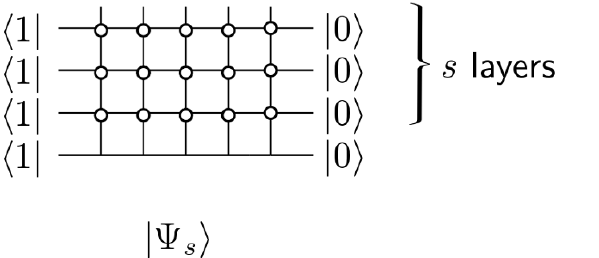
Figure 17 . An MPS/MPO representation of the vector j (cid:9) s i = S s rank-1-boundary tensor X = ( j 0 ih 1 j ) (cid:10) s +1